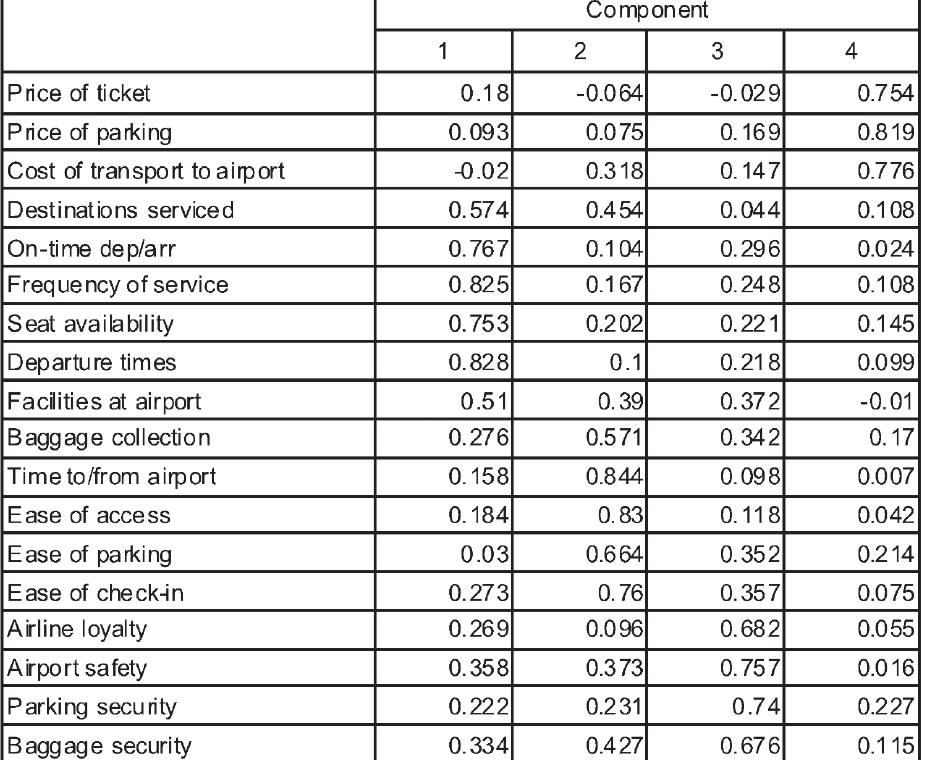
Table 9: Confirmatory factor analysis (four